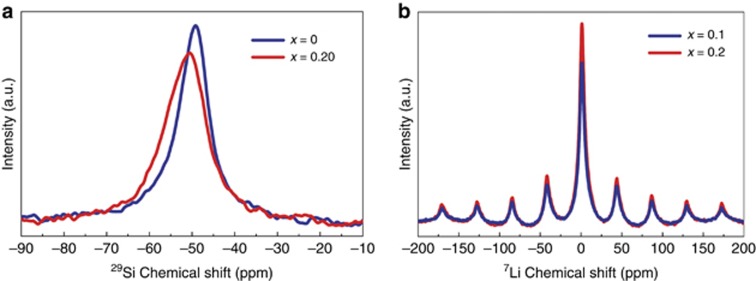
29Si (a) and 7Li (b) solid state NMR spectra of Ca1−xLixAl1−xSi1+xN3:Eu2+ with different compositions.